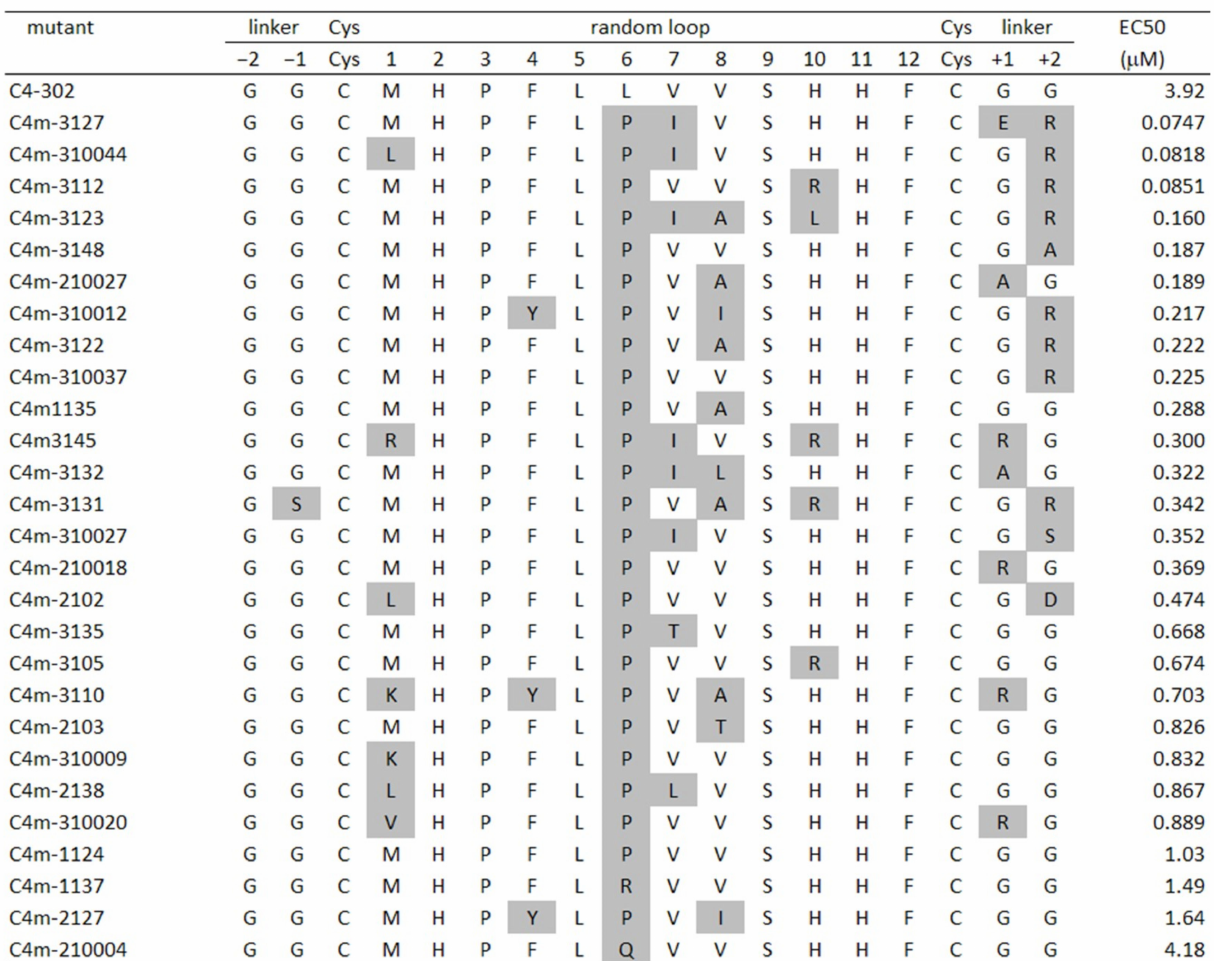
Figure 4. Affinity ranking of MBP fusion peptide using ELISA-based EC 50 values. Amino acid sequences of many clones obtained from affinity maturation for C4-302 are shown. Residues high- lighted in gray indicate mutated sites. Leu6 in random loop region of C4-302 was predisposed to mutate into proline. Although mutation in N-terminal GG linker was rarely observed, GG linker in C-terminus tended to mutate into hydrophilic residues such as arginine. ELISA-based EC 50 values were determined using MBP fusion peptide that was overexpressed in E. coli as a fusion protein with an N-terminal MBP and then